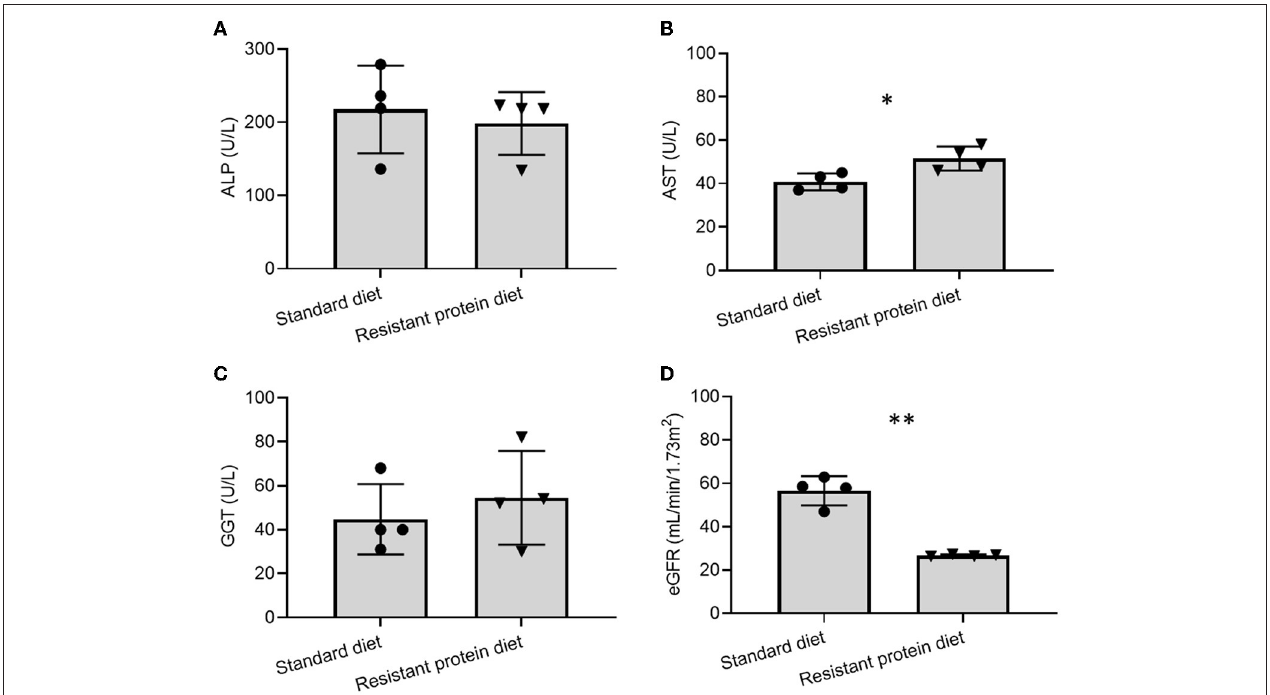
FIGURE 3 | Comparison of effects of standard and resistant proteins diets on the biomarkers of liver and renal function, showing results for (A) alkaline phosphatase (ALP), (B) aspartate aminotransferase (AST), (C) gamma-glutamyl transferase (GGT), and (D) estimated glomerular filtration rate (eGFR). Results represent the mean and SD of data, with dots indicating individual data points. Statistical difference between groups is designated as follows: * p = 0.019, ** p <